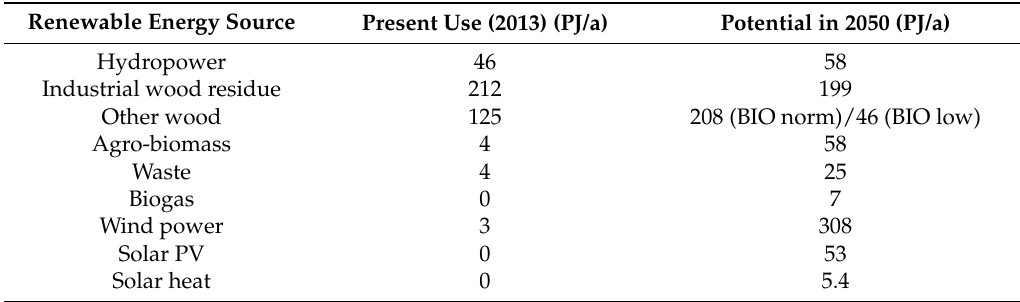
Table A1. Renewable energy potentials in the national case. The potentials are based on Reference [47], with the exception of wind power (50 GW, [54]).